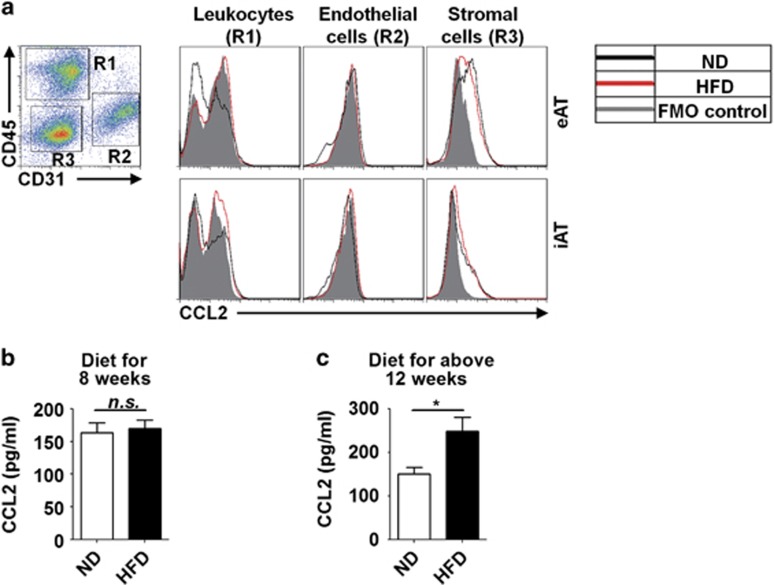
The level of CCL2 in adipose tissue and serum. (a) Flow cytometric analysis of CCL2 expression in leukocytes, endothelial cells, and stromal cells in eAT and iAT from ND- or HFD-treated mice. Representative dot plots are shown. CD45+ cells (R1) represent leukocytes, CD31+ cells (R2) represent endothelial cells, and CD45− CD31− cells (R3) represent stromal cells. (b and c) CCL2 expression level in serum of mice at early-stage (treated with diet for 8 weeks) (b) or relatively late-stage (treated with diet for >12 weeks) of obesity (c). Means±S.E.M. are shown. n=5–8 mice in each group, *P<0.05